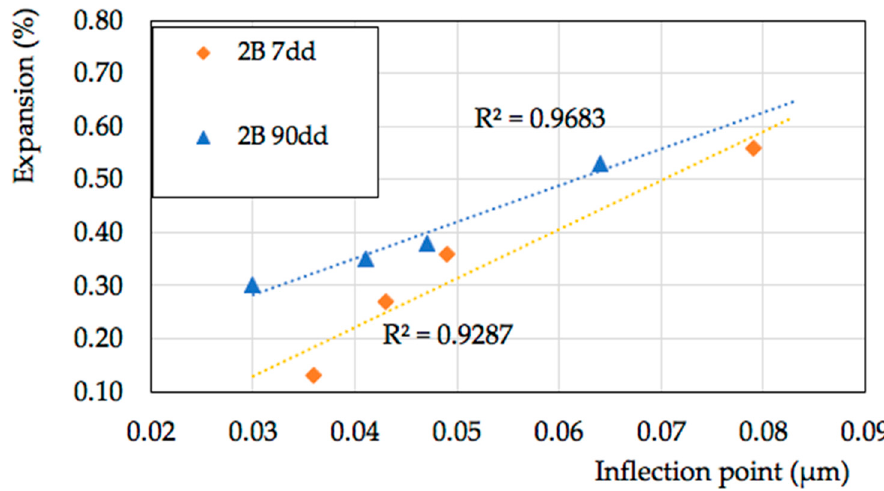
Figure 15. Expansion vs. dimension of the most frequent pore for samples 2B 7dd and 2B 90dd at the longer curing times, i.e., 30 days (R 2 values for linear interpolation reported).